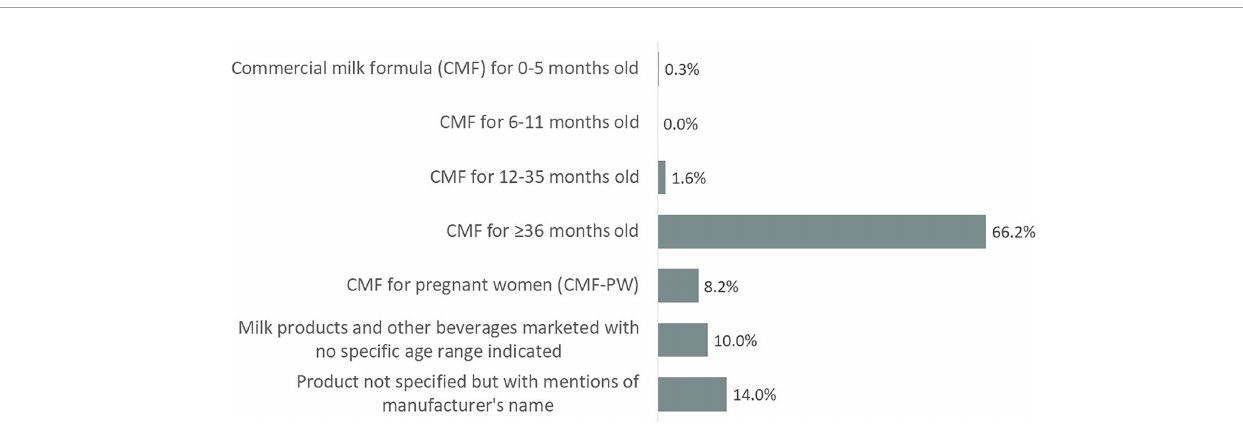
FIGURE2 Distribution of CMF and milk products and other beverages marketed with no specific age range indicated promotion in unique materials ( n =